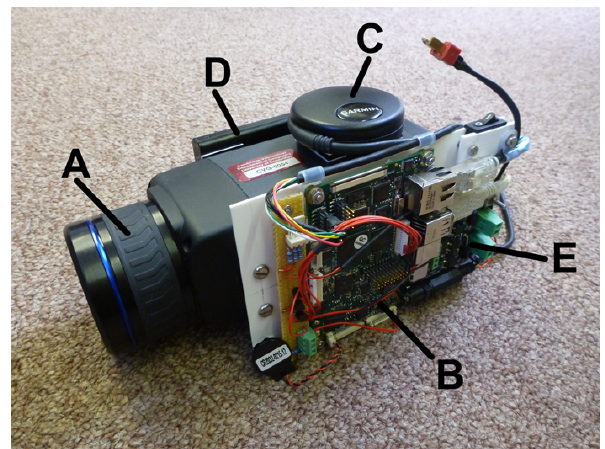
Fig. 1. The main components of the camera system: (A) FLIR SC645 IR-camera, (B) BCT-RE2 SBC, (C) Garmin GPS 18 LVC, (D) Intel 256 Gb SSD, (E) Phidgets